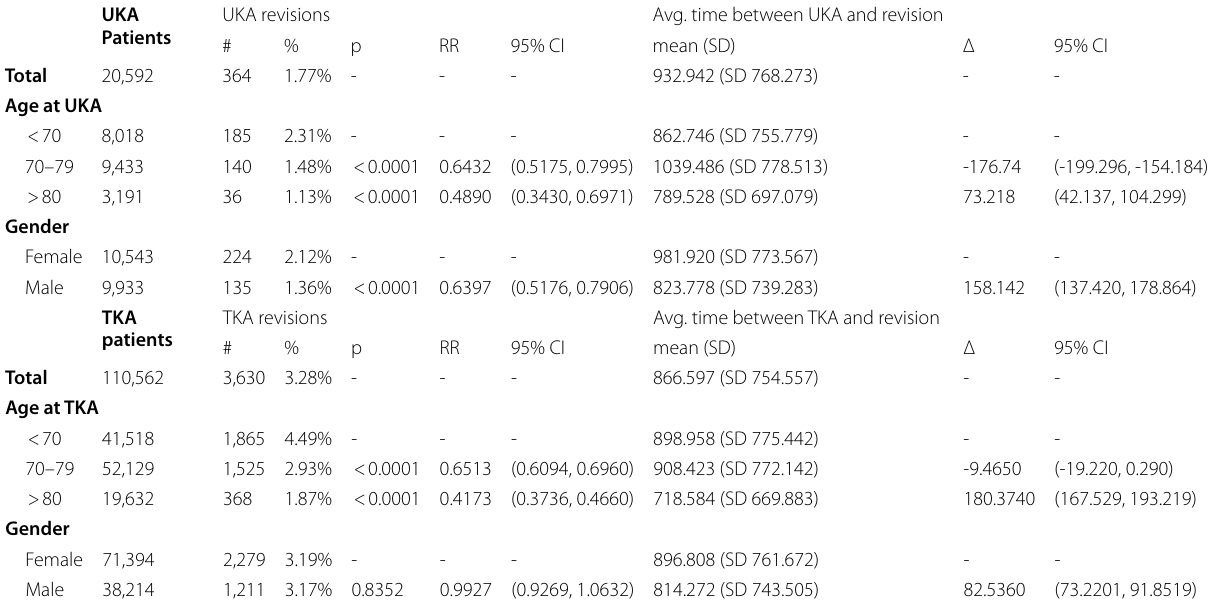
Table 12 Time until revision for UKA and TKA UKA Patients